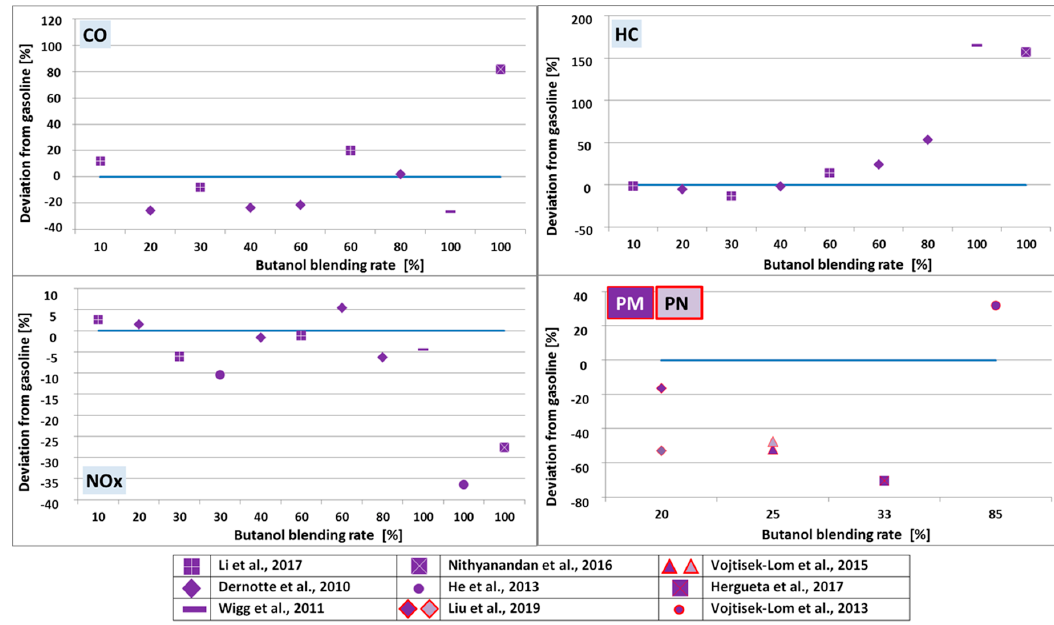
Figure 16. Deviation of gaseous and particulate pollutant emissions from butanol-gasoline blend combustion from those of neat gasoline fuel combustion depending on the butanol blending rate. Data derived from: Wigg et al., 2011 refers to [46], Li et al., 2017 refers to [47], Nithyanandan et al., 2016 refers to [48], Dernotte et al., 2010 refers to [50], He et al., 2013 refers to [55], Liu et al., 2019 refers to [58], Vojtisek-Lom et al., 2015 refers to [59], Hergueta et al., 2017 refers to [60], and Vojtisek-Lom et al., 2013 refers to [61].